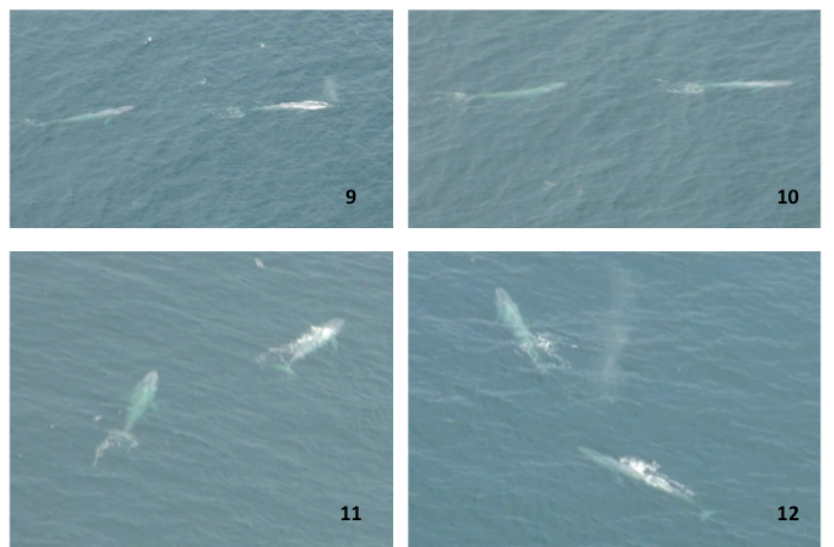
Figure 6. Photos of the lead pair ( 9, 10, 11, 12 ) among a group of 3 blue whales on 29 July